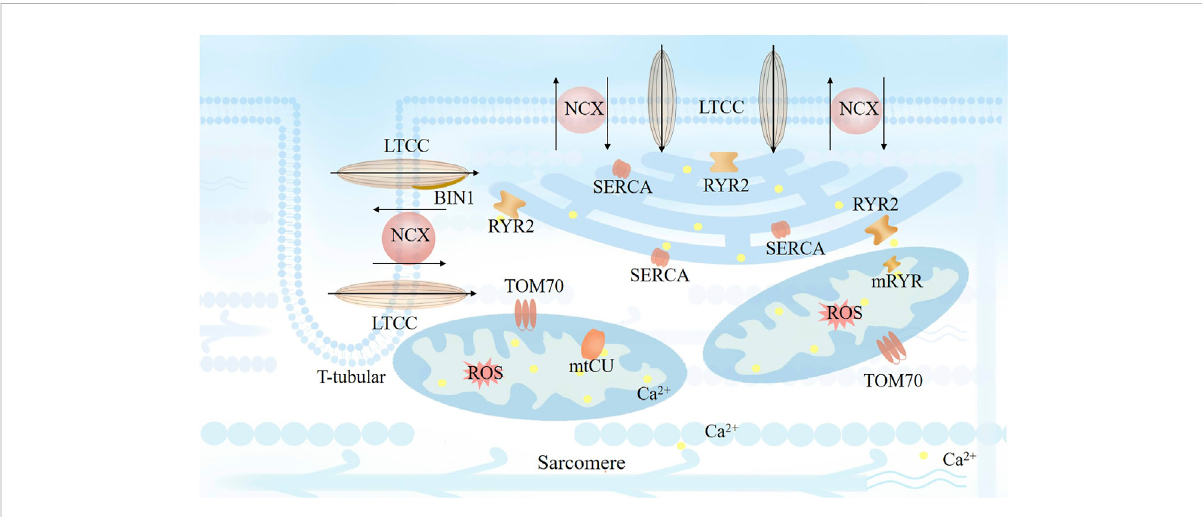
FIGURE 1 Cardiomyocyte excitation-contraction (EC) coupling based on the close spatial and arrangement localization of the dyads. Transverse tubule (T-tubule) depolarization is mediated by coupling L-type Ca2+ channels (LTCCs) next to ryanodine receptors (RyRs), which activates RyR2 channels byasmallamountofCa2+entrythroughLTCCsandleadtoafollowinglargeamountcalciumreleasemediatedbyRyR2.Bridgingintegrator1(BIN1) facilitates LTCC localization to T-tubule membrane. The released Ca2+ from SR would be reuptake by SR calcium ATPase (SERCA) on every cardiac cycle to sustain a steady state with stable Ca2+